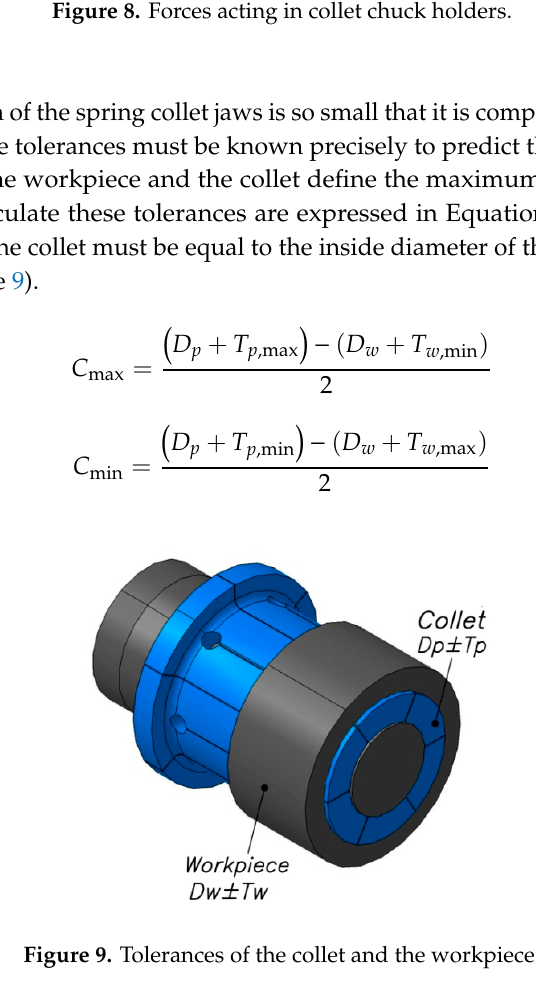
Figure 9. Tolerances of the collet and the workpiece.